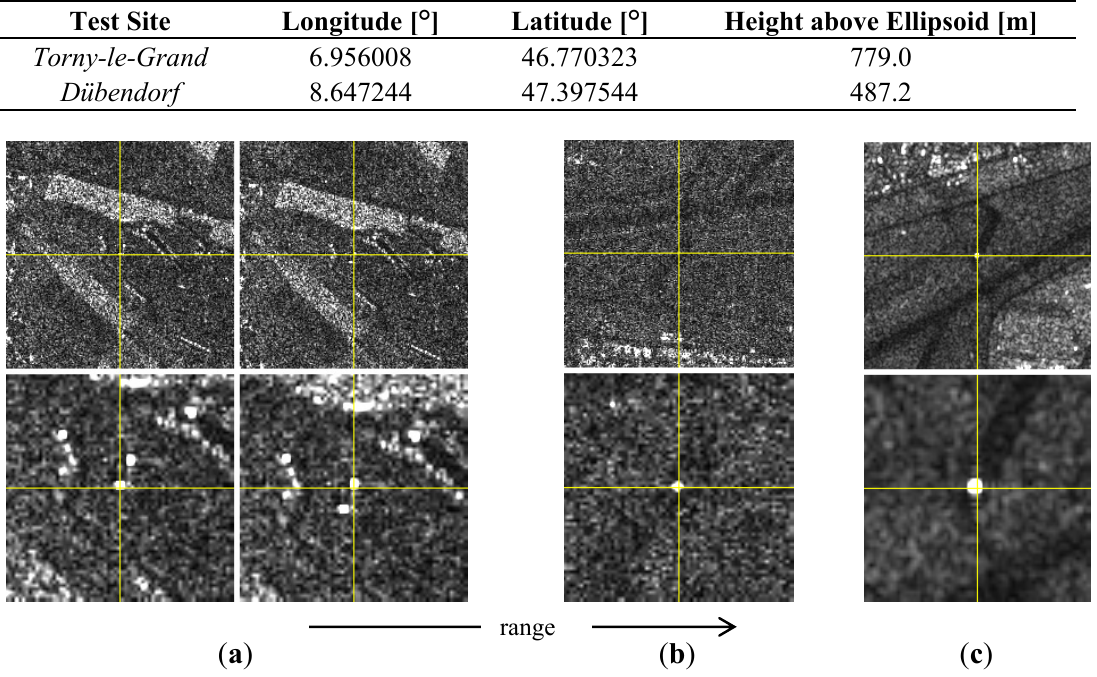
Table 2. Approximate test site positions in WGS84 geographic coordinates.